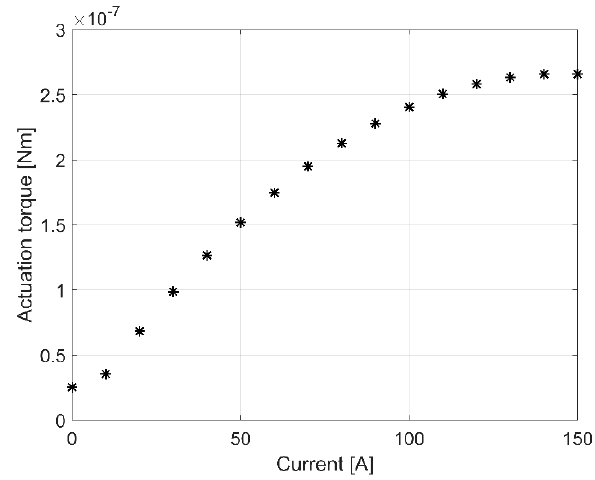
Figure 5. Actuation torque versus current, referred to the prototype for a rotation angle φ = 10°.